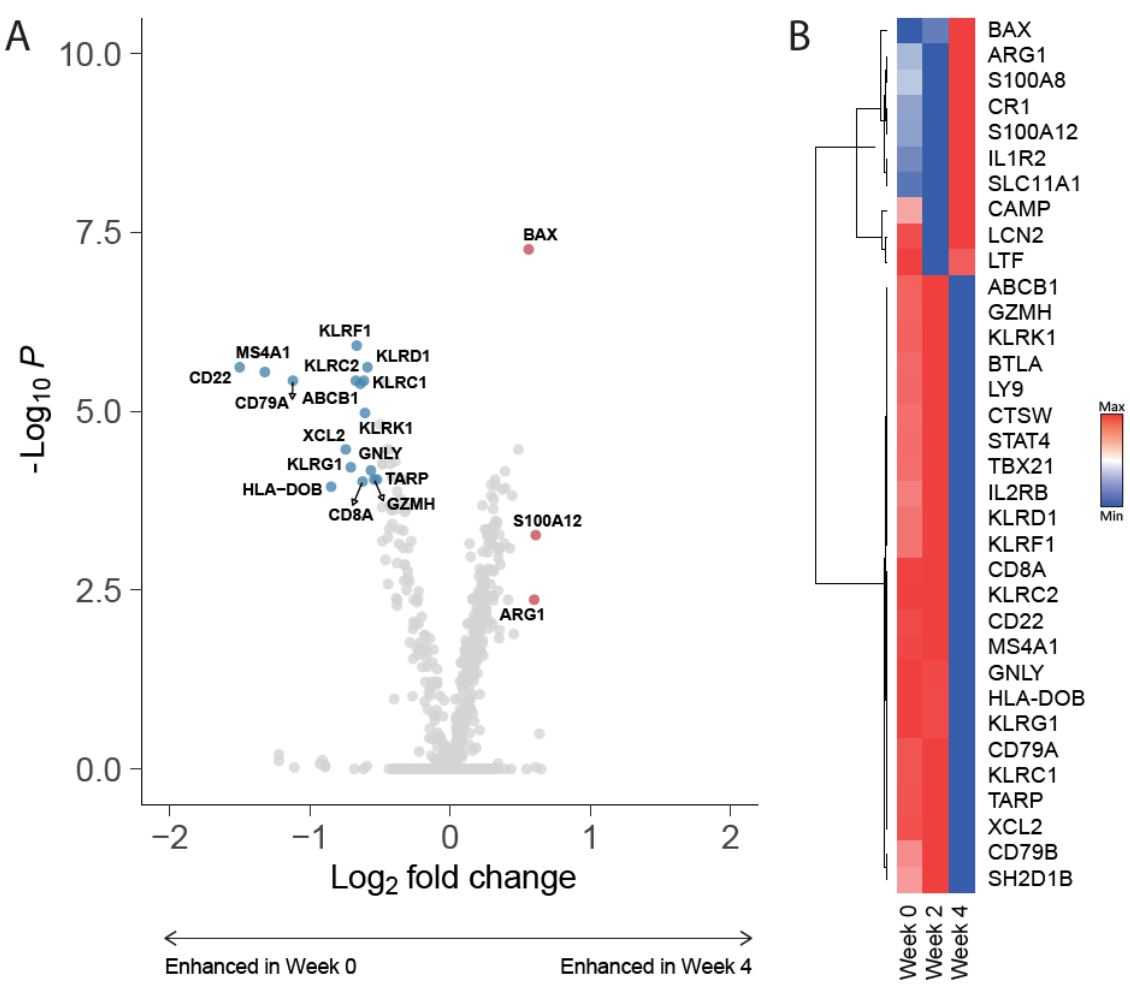
Figure 2. SBRT/IMM-101 induced gene expression. ( A ) Volcano plot demonstrating genes upregu- lated at baseline versus week 4. Highlighted genes underwent a log 2 fold change < − 0.5 or >0.5 and p -value < 0.05. ( B ) Heat map of significantly differentially expressed genes between week 0, week 2 and week 4.